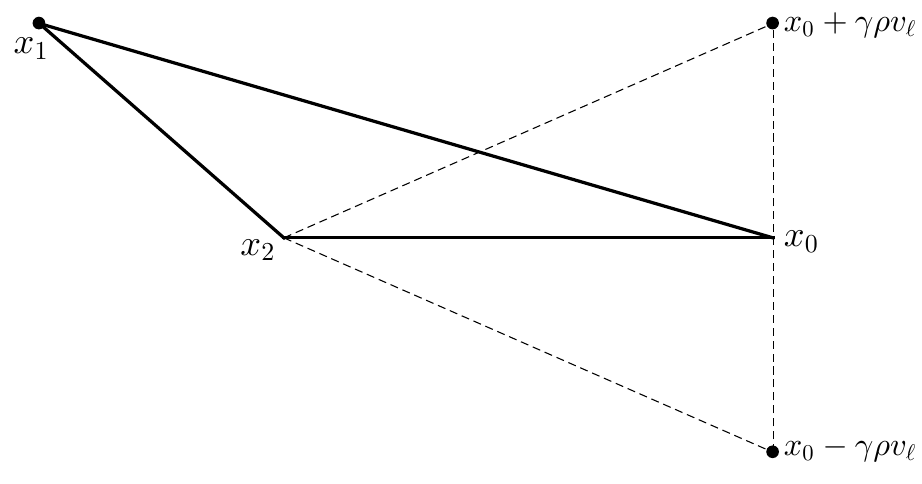
Figure A5. Illustration of the new vector x ∆ , generated to improve the shape of the simplex. The vertex x 1 is replaced with either x ∆ = x 0 + γρ v (cid:96) or x ∆ = x 0 − γρ v (cid:96) , whichever point results in a smaller value of ˆ Φ